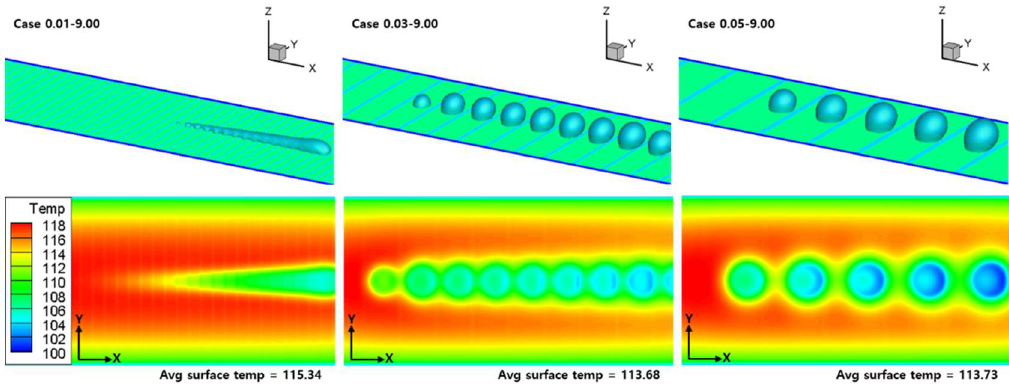
Figure 10. Bubble nucleation and surface temperature according to pattern pitch; Time step = 30,000; 9.00 pattern ratio.